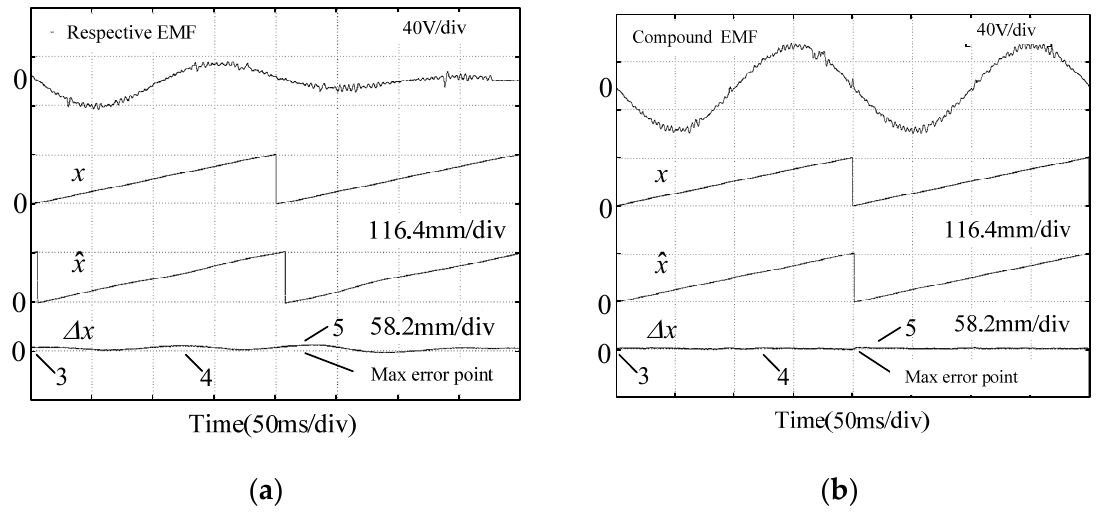
Figure 12. The estimated position in different methods. ( a ) Back-EMF in the respective segment; ( b ) compound back-EMF. Table 3. The error of the mover position.